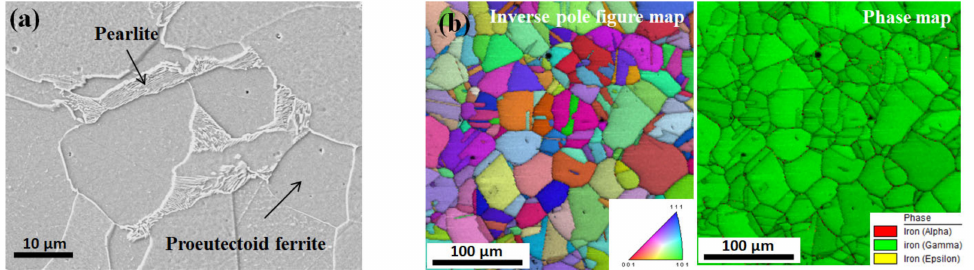
Figure 5. Microstructure of the hot-rolled ( a ) low-carbon and ( b ) TWIP steels used in this